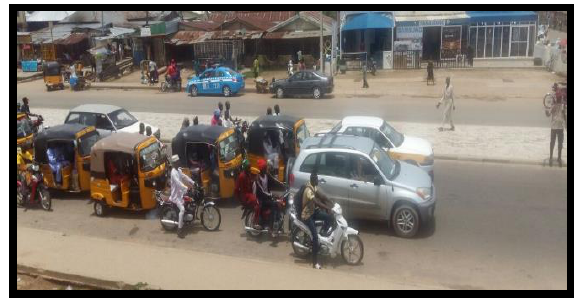
Figure 5. Instance of Adherence of Road Users to Traffic rules in the Presence of FRSC Officers